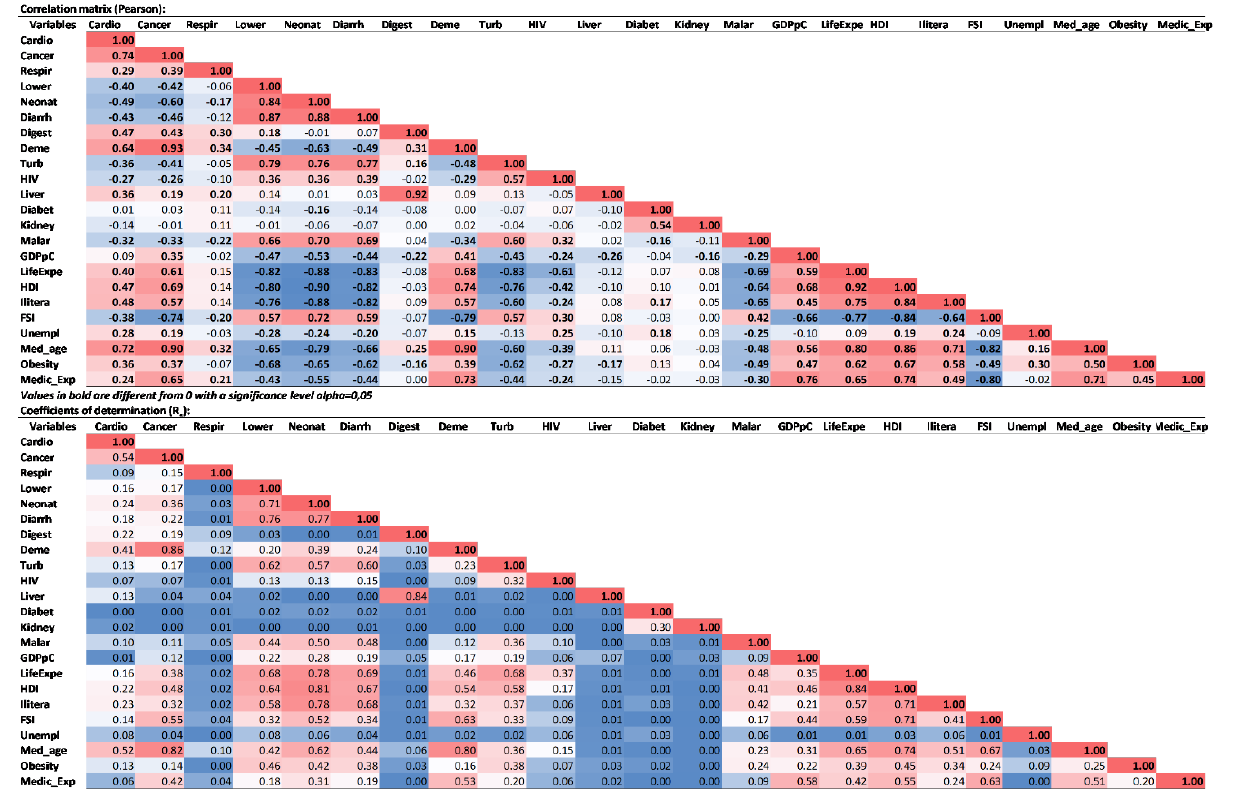
Figure 8. Bravais–Pearson linear correlation and linear regression. Source of data: The Institute for Health Metrics and Evaluation, World